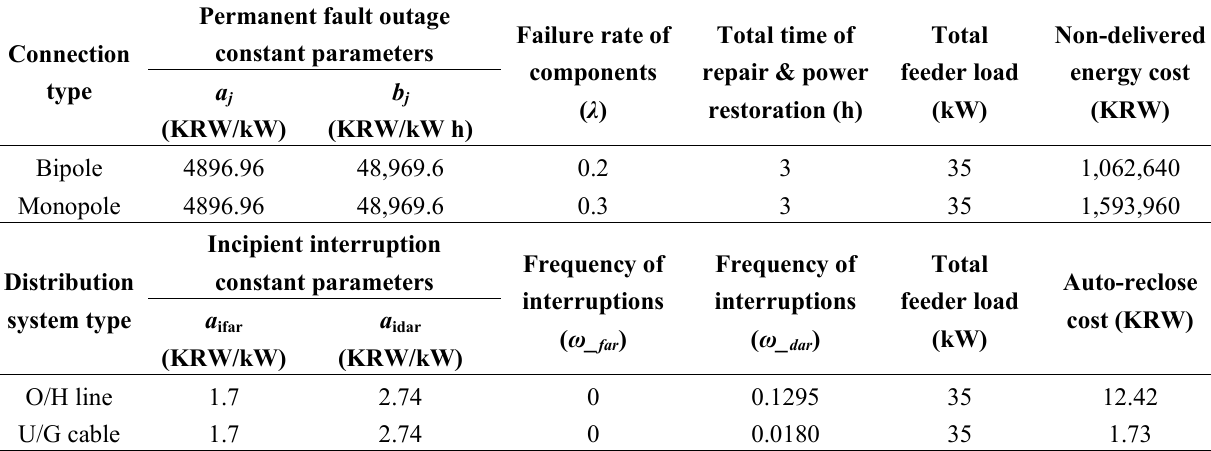
Table 11. Interruption and outage costs of